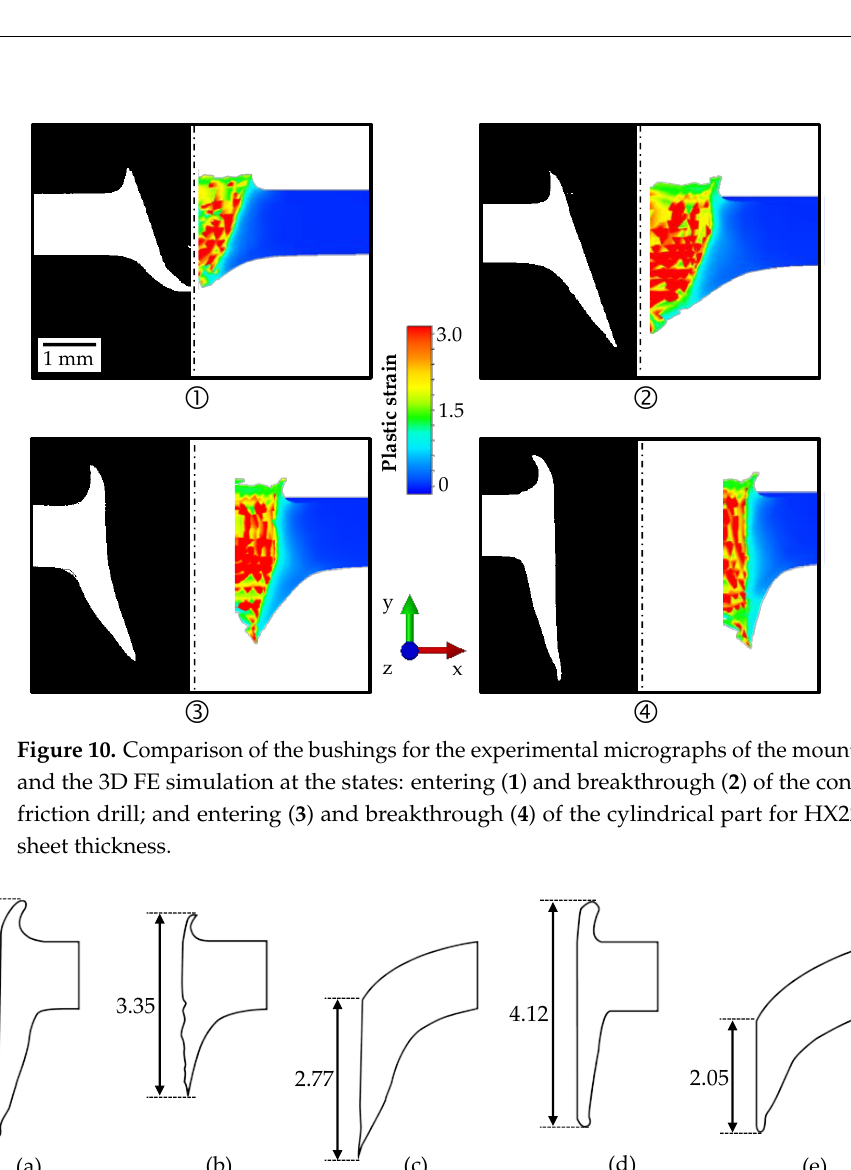
Figure 12. Comparison of the bushings for the experimental micrographs and the 3D FV simulation in the states: entering ( 1 ) and breakthrough ( 2 ) of the conical part of the friction drill; and entering ( 3 ) and breakthrough ( 4 ) of the cylindrical part for HX220 at a 1.2 mm sheet thickness. A comparison of the temperature measurements from the experiments and the FV simulation are shown in Figure 13. In Figure 13a, the position of the spot-welded thermo- couple (MP) and three measuring points (MP1–3) are depicted. The thermocouple was